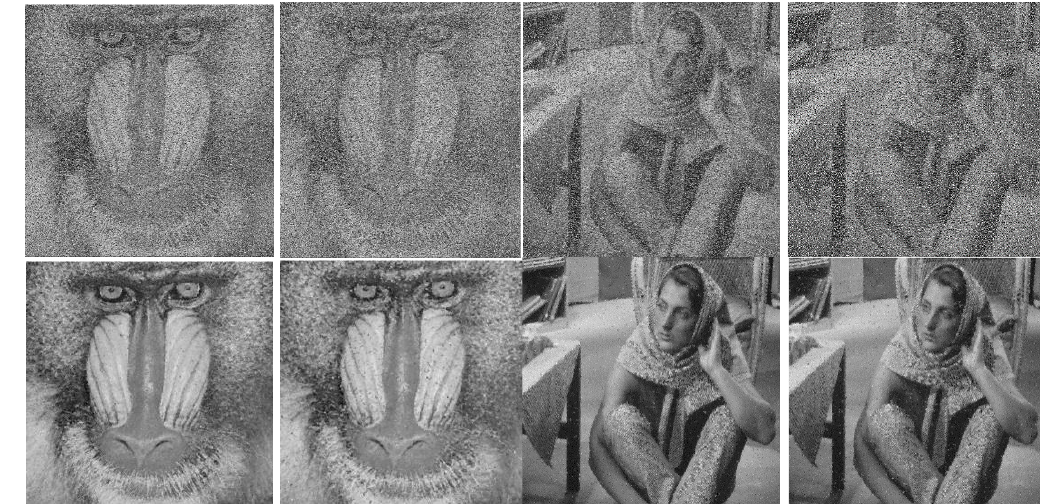
Figure 9. First row shows two noise corrupted images 50% and 60% RVIN of Baboon and Barbara images respectively. Second row shows the de-noised results after applying the proposed filter.